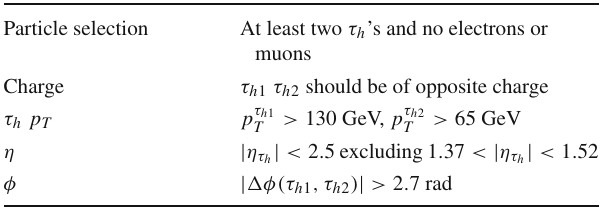
Table 3 Summary of the experimental cuts for the ATLAS τ h τ h search [44]. For the leading τ h we use the p T cut p the HEPData entry for Ref. [44]. Note that the corresponding cut was p τ h